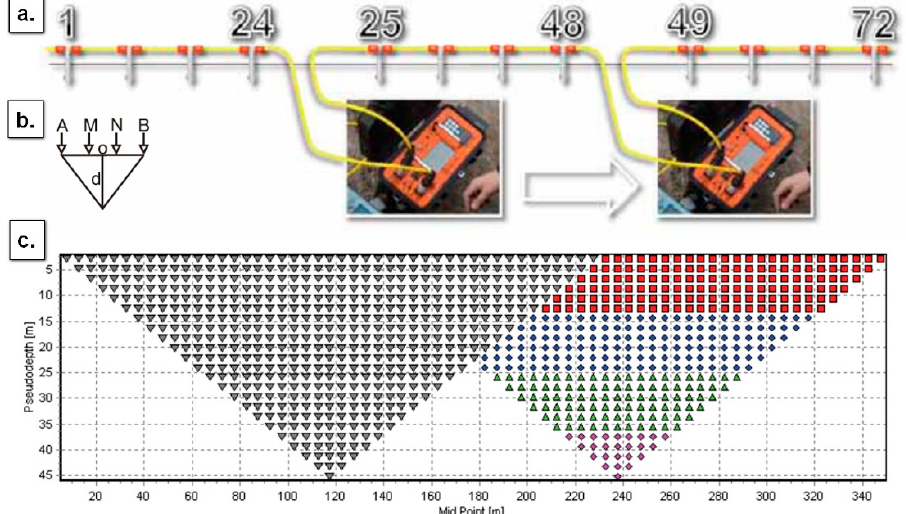
Figure 4. ERT measurements. ( a ): Electrodes and cables connected to the SKALA system. ( b , c ): Symmetrical sounding array ( b ) and resistivity data points ( c ).